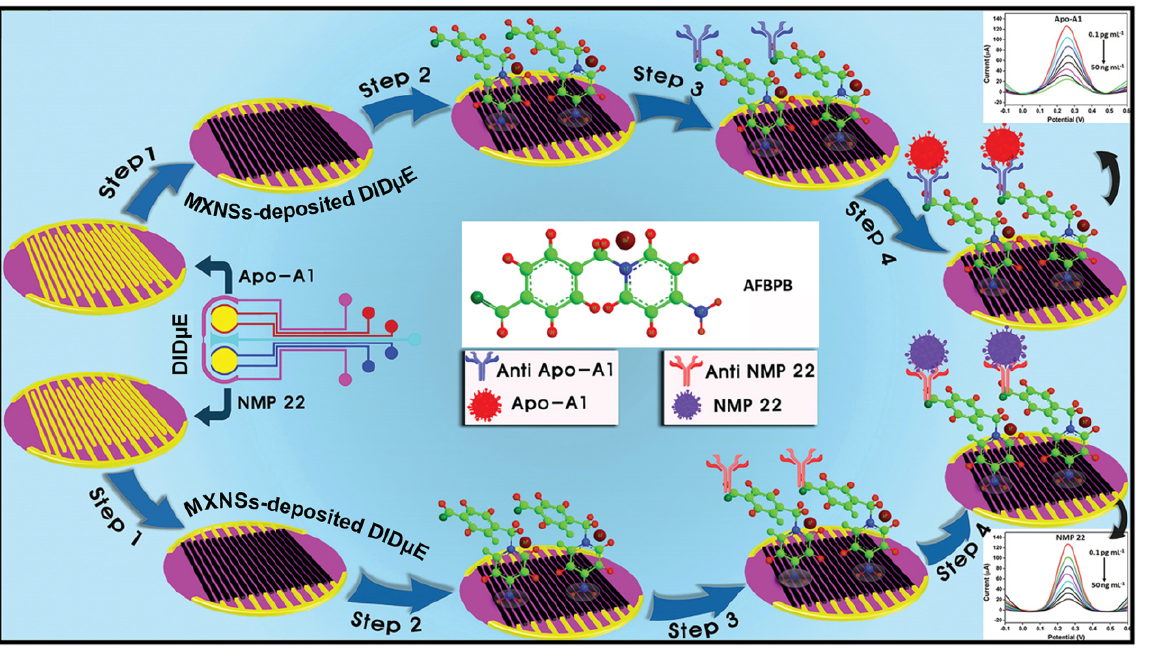
Figure 3. Schematic illustration of the fabricating procedure of the immunosensor for Apo–A1 and NMP 22 detection. Adapted with permission from Ref. [53]. 2020, Wiley–VCH GmbH. NMP 22 detection. Adapted with permission from Ref. [53]. 2020, Wiley–VCH